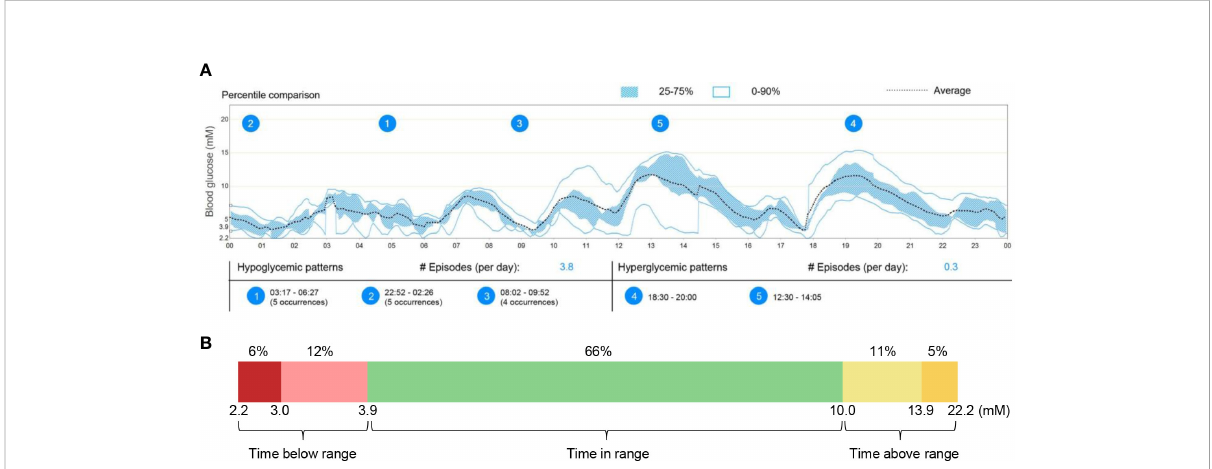
FIGURE 1 Continuous glucose monitoring in this patient from September 25-30, 2020. (A) Averaged and percentile blood glucose levels during this 6-day continuous monitoring. The patterns and occurrences of hypoglycaemic and hyperglycaemic episodes were provided. (B) Quanti fi cation of time below range (2.2-3.9mM), time in range (3.9-10.0mM), and time above range (10.0-22.2mM) during the whole glucose monitoring.